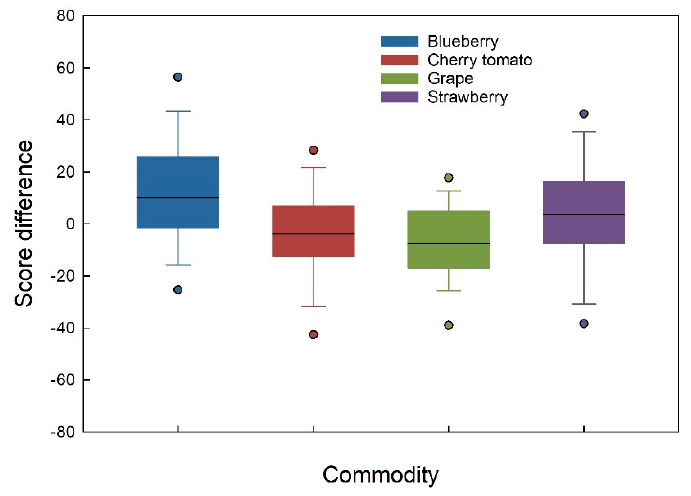
Figure 4. Boxplot represents the texture firm (IT-TF). The dots represent outliers.